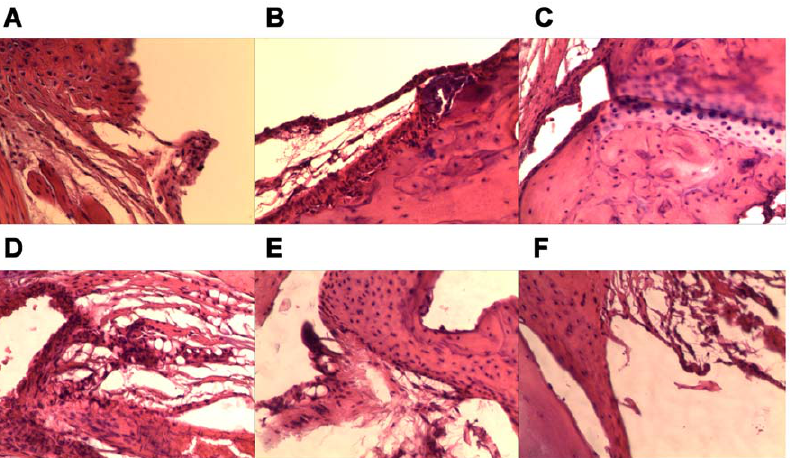
Figure 8. Histological amelioration of synovitis by anti-arthritis therapies in CIA and BIA-CIA mice (HE staining, 6 200). A and B. Pre- treatment of CIA (intra-articular CII-CFA injection) mice with 60 m g/ml artesunate or 50 m g/ml rapamycin; C and D. Post-treatment of CIA (intra-dermal CII-CFA injection) mice with 60 m g/ml artesunate and 50 m g/ml rapamycin, or 50 m g/ml rapamycin and 15% alcohol; E and F. Post-treatment of BIA- CIA (intra-dermal CII-CFA injection) mice with 60 m g/ml artesunate and 50 m g/ml rapamycin, or 50 m g/ml rapamycin and 15% alcohol. HE staining of sections and microscopic analysis were carried out by sampling hind paws of mice after therapy completion.